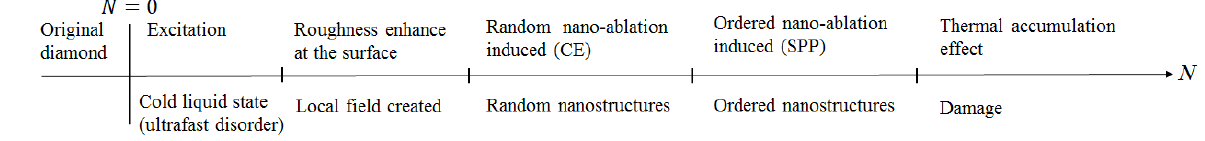
Figure 10. A proposed scenario for HSFL formation during multipulse femtosecond laser